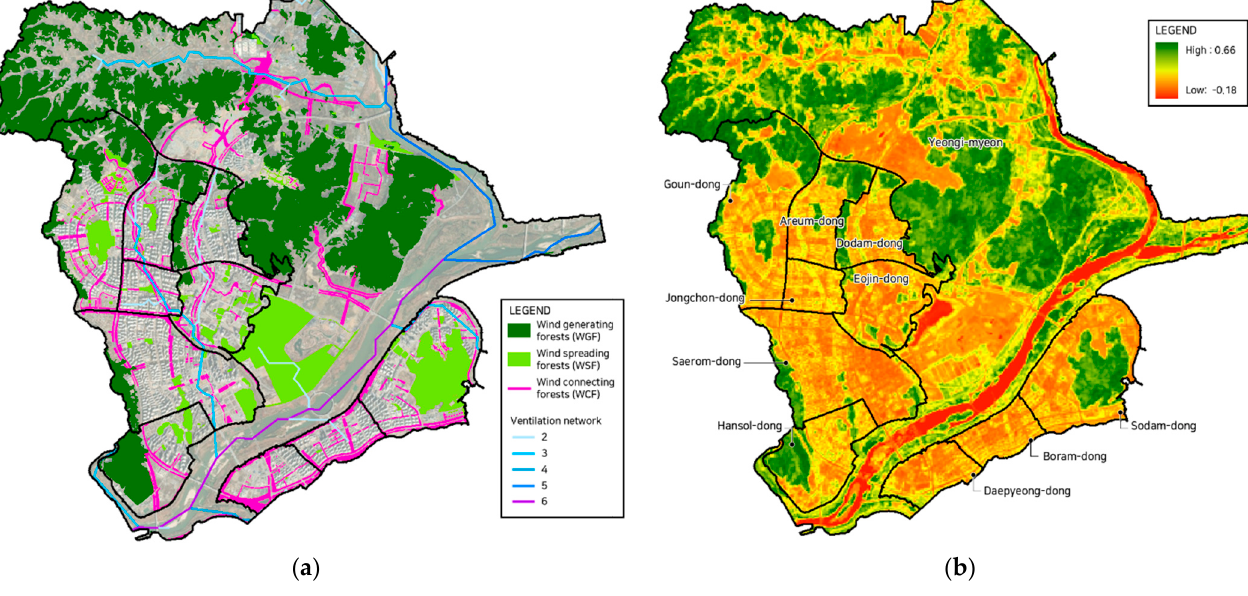
Figure 7. The overall conditions of wind corridor forests in HBC region: ( a ) wind corridor forests; ( b ) vegetation index of wind corridor forests.